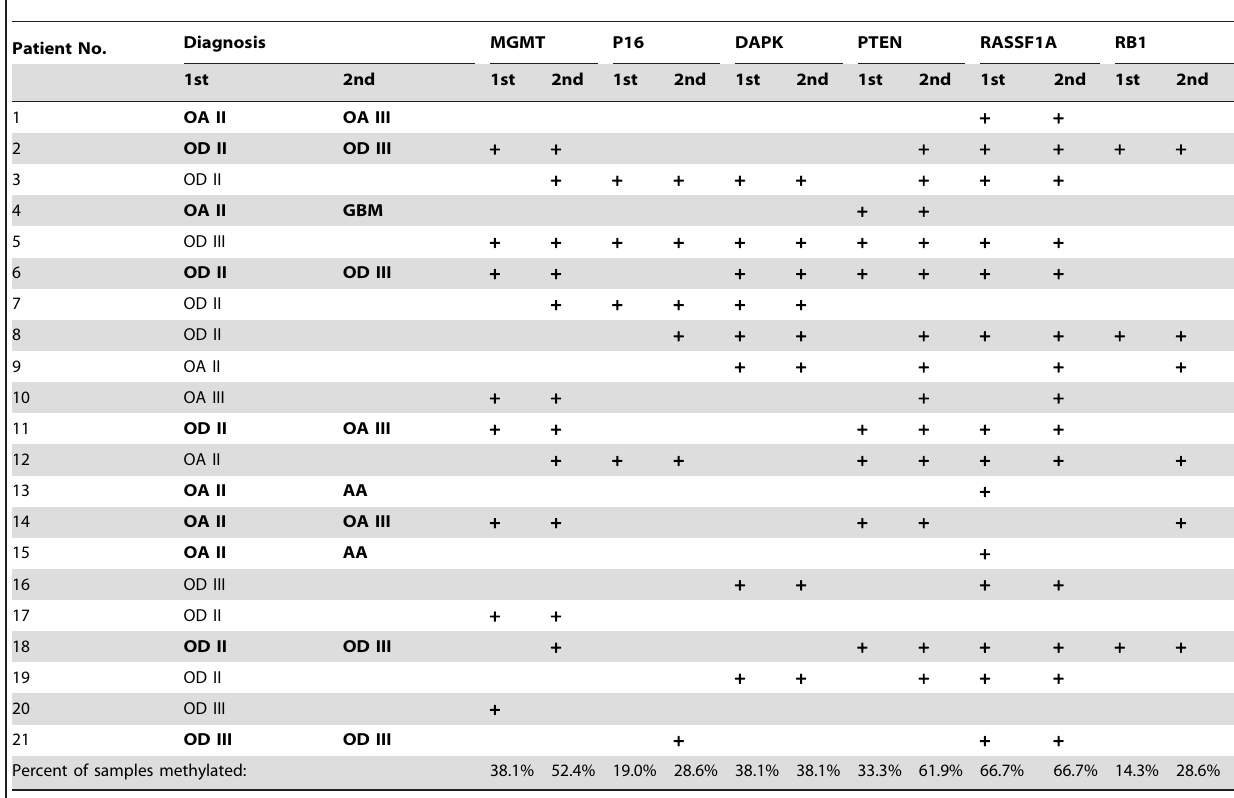
Table 4. Methylation status of tumor gene promoters in longitudinal samples a .